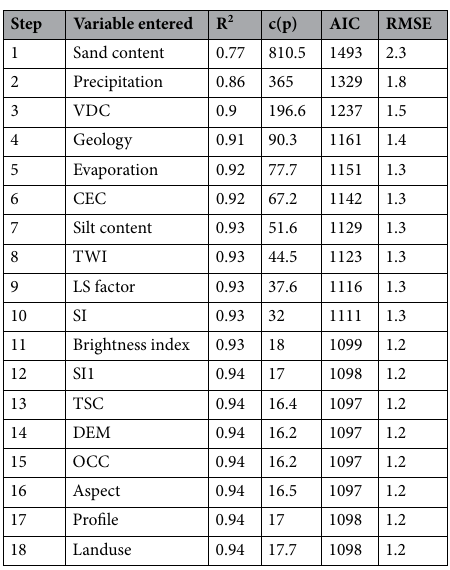
Table 3. The results of controlling factor selection by